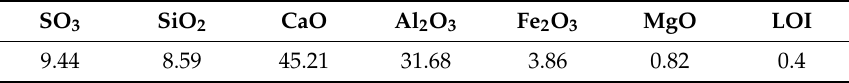
Table 1. Chemical composition of CSA clinker (wt.%).